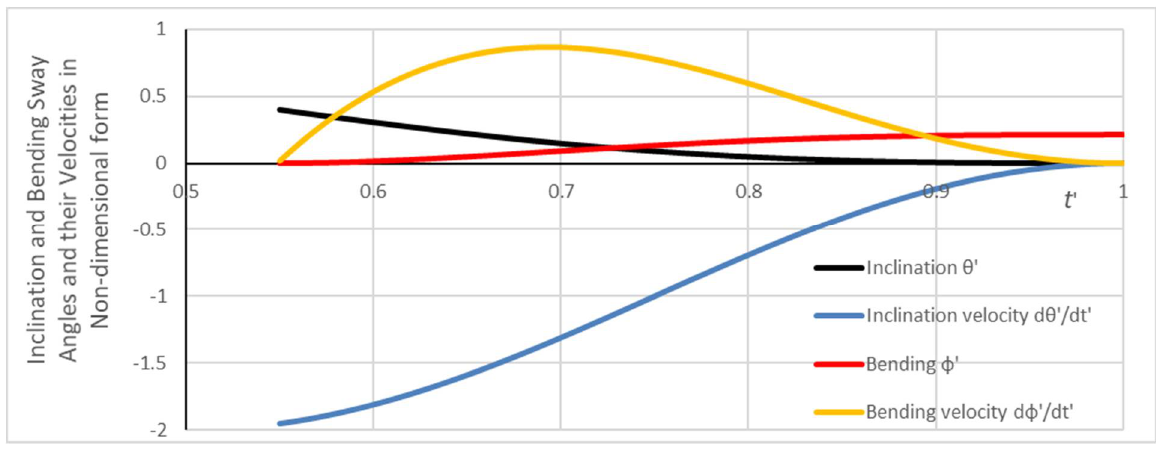
'd  and Bending Sway   '' t  ,   ' t 'd t